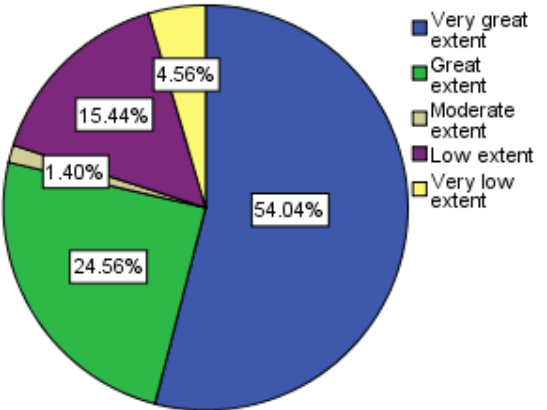
Figure 6. Pie chart showing the responses on exemplification